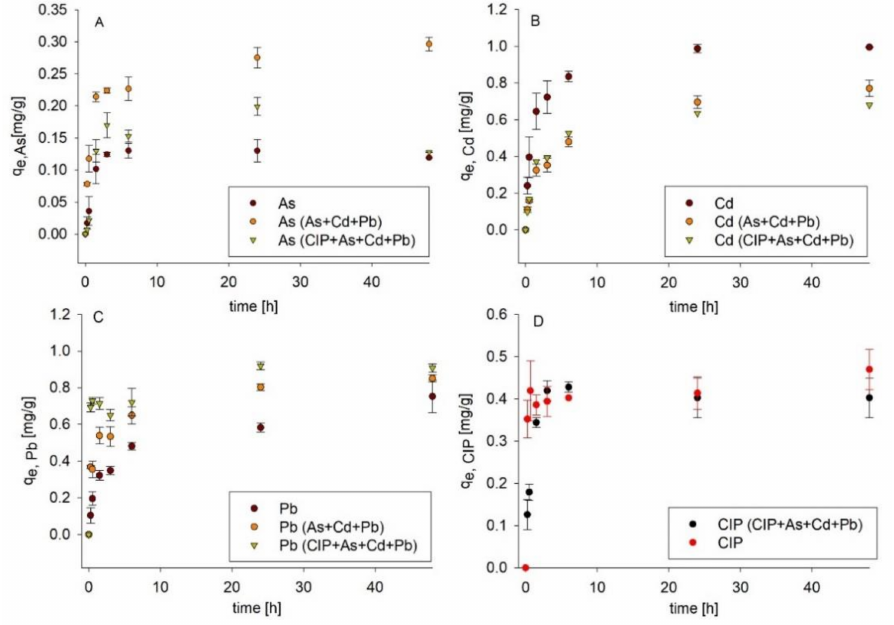
Figure 4. Kinetic curves of ( A ) As, ( B ) Cd, ( C ) Pb and ( D ) ciprofloxacin (CIP) individually and in